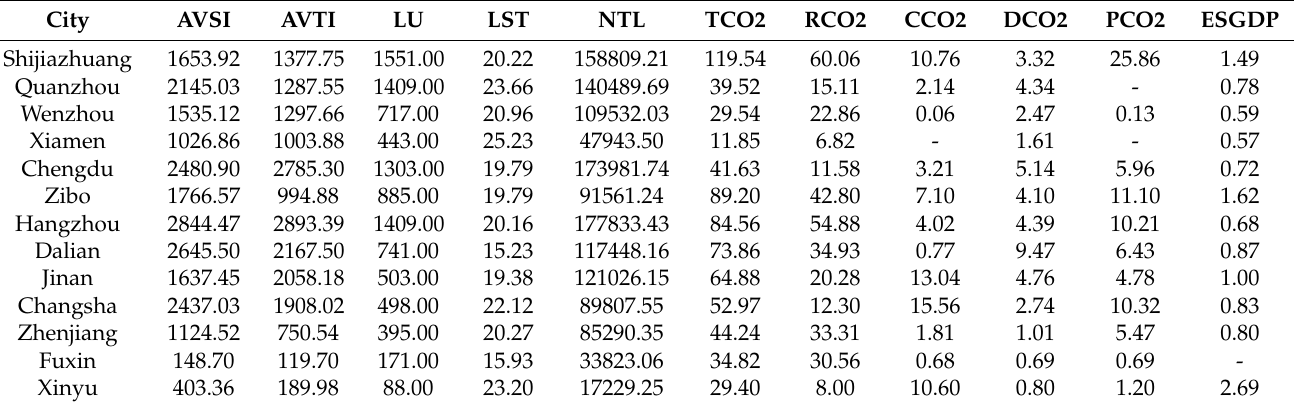
Table 5. Data on the